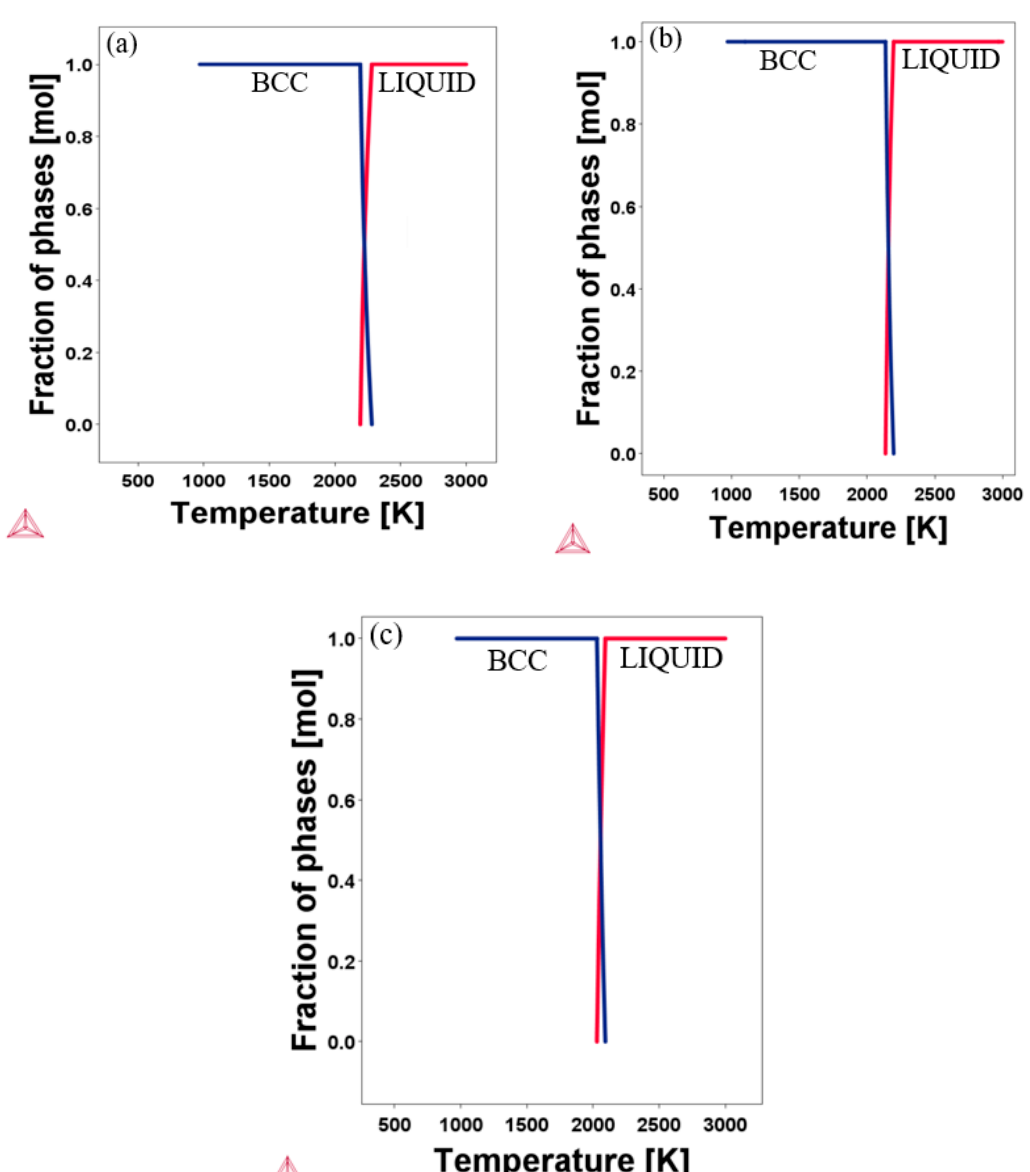
Figure 2. Calculated equilibrium phase diagrams of the RHEAs at high temperature: ( a )